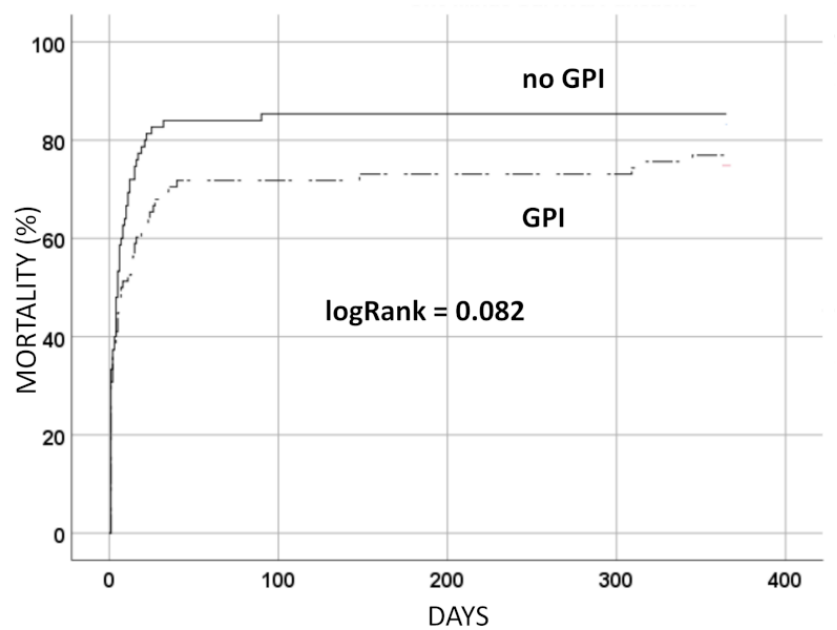
Figure 2. Unadjusted all-cause mortality at one year. GPI = glycoprotein IIb/IIIa receptor